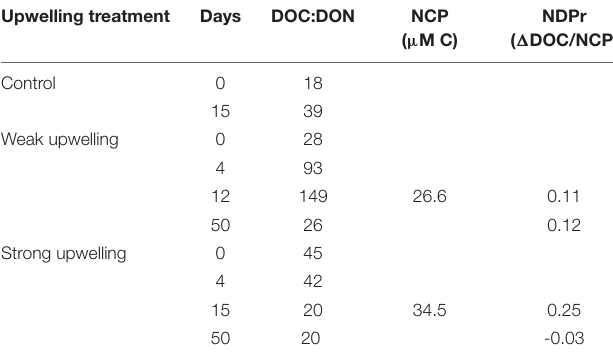
TABLE 2 | Derived variables for light and dark incubations in the given